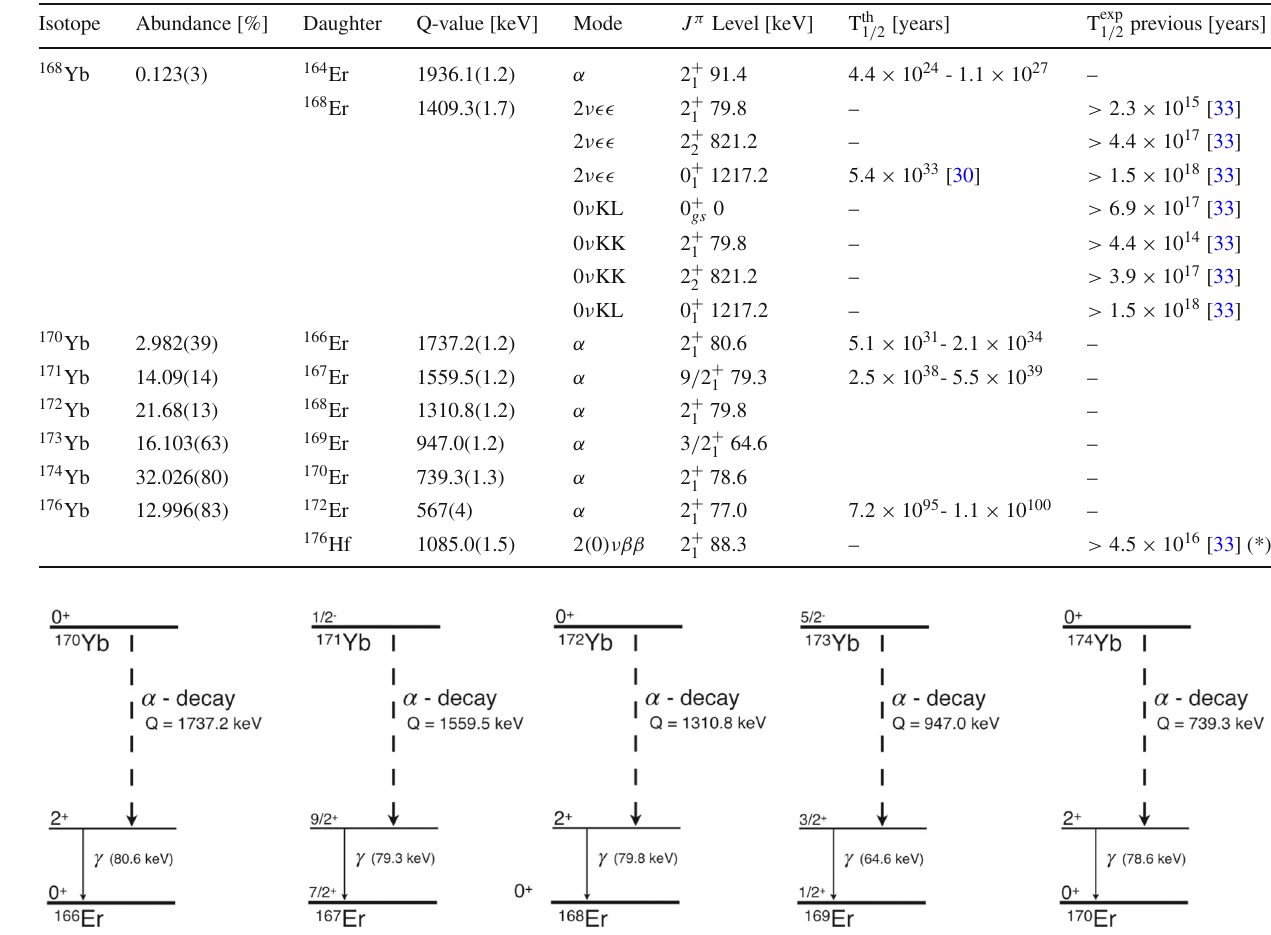
Fig. 1 Decay schemes of Yb isotopes with α -decay modes as investigated in this work. Data taken from